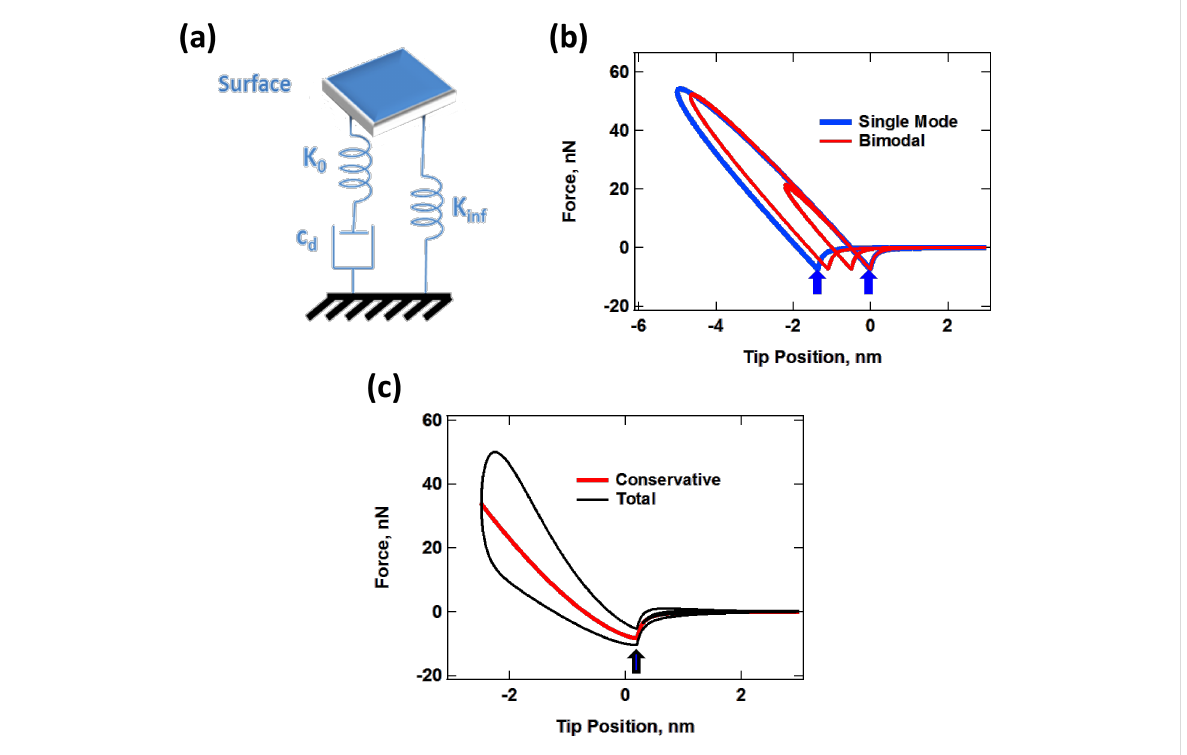
Figure 1: (a) Standard linear solid (SLS) model [10]; (b) simulated tip–sample force trajectories for single- and dual-mode (bimodal) AFM impacts by using the SLS. The key difference between the single- and dual-mode interactions is the possibility of multiple impacts as well as the variation in the shape of successive impacts in the latter [41,42]. The horizontal distance between the two blue arrows indicates the distance that the surface relaxed during the tip–sample contact time for the single-mode case. (c) Simulated tip–sample force trajectory by using a Hertzian contact model with a depth- dependent dissipation coefficient [34,42]. For all force curves shown, the trajectory around the dissipation loops proceeds in the counterclockwise direction.